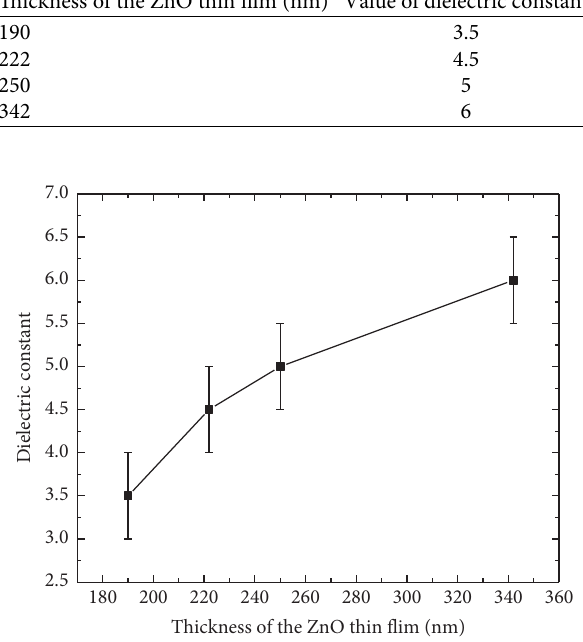
Figure 3: Variation of the dielectric constant of ZnO thin films with respect to film thickness. Table 2: Variation of dielectric constant of ZnO nanoparticles with respect to the particle